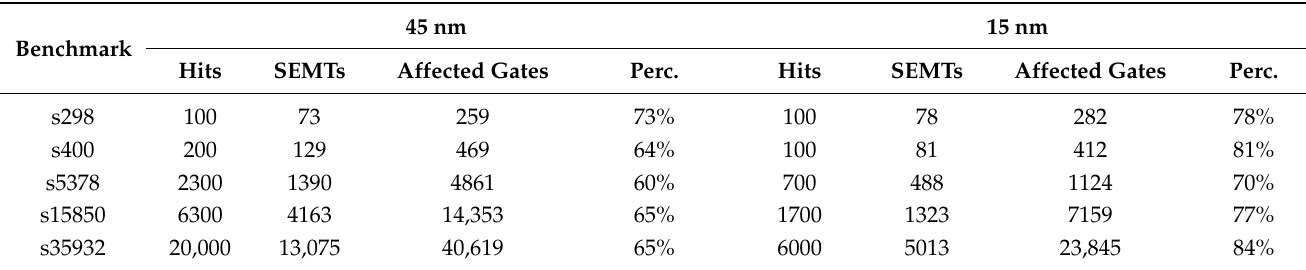
Table 5. The overall number of multiple affected gates, the number of hits implemented, and the percentage of particles, which provoke